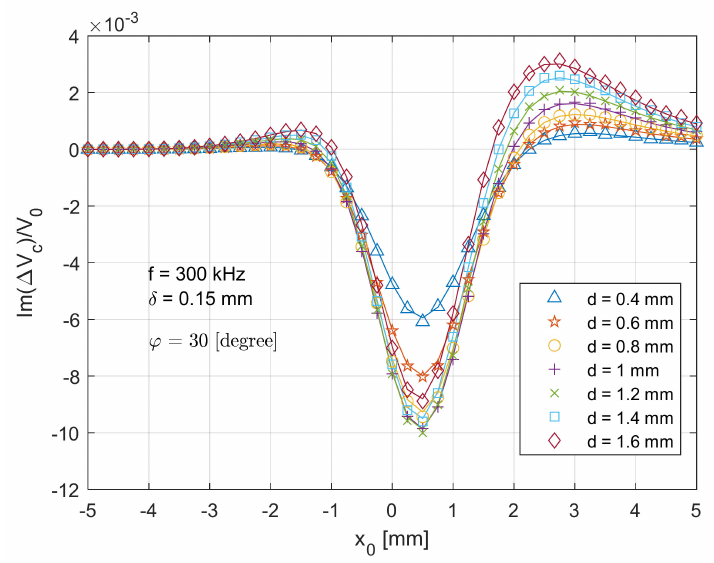
Figure 10. Comparison of analytical (lines) and experimental (markers) results for the imaginary part of normalised voltage change (due to the crack) for the T-R sensor (tilt angle ϕ = 30 degrees) scanning across ( x direction in Figure 2) and through the crack